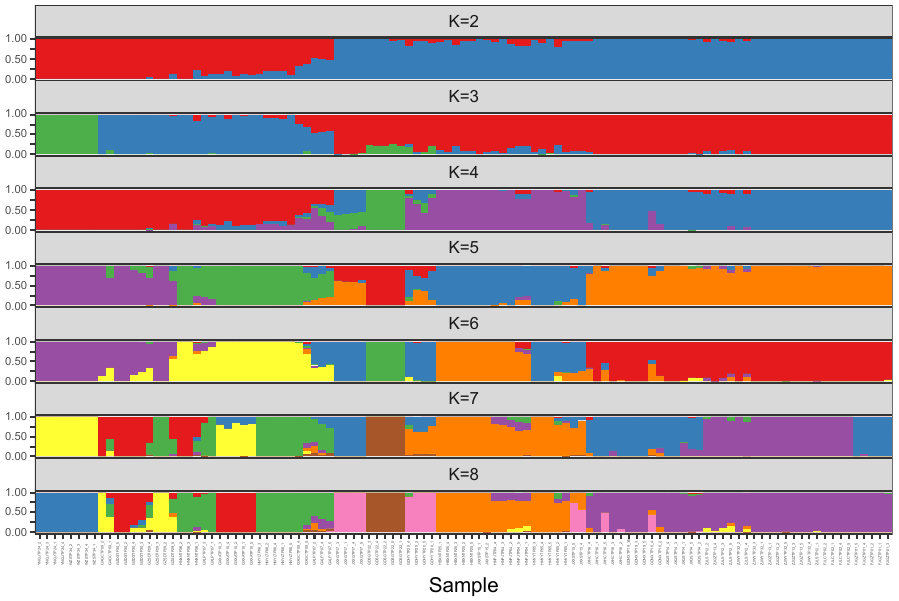
Figure 3. Genetic structure of cultivated 109 D. catenatum for K = 2–8 based on the Admixture software (K = 2 with cross validation error is 0.18580, while K = 3 with ross validation error is 0.19141).